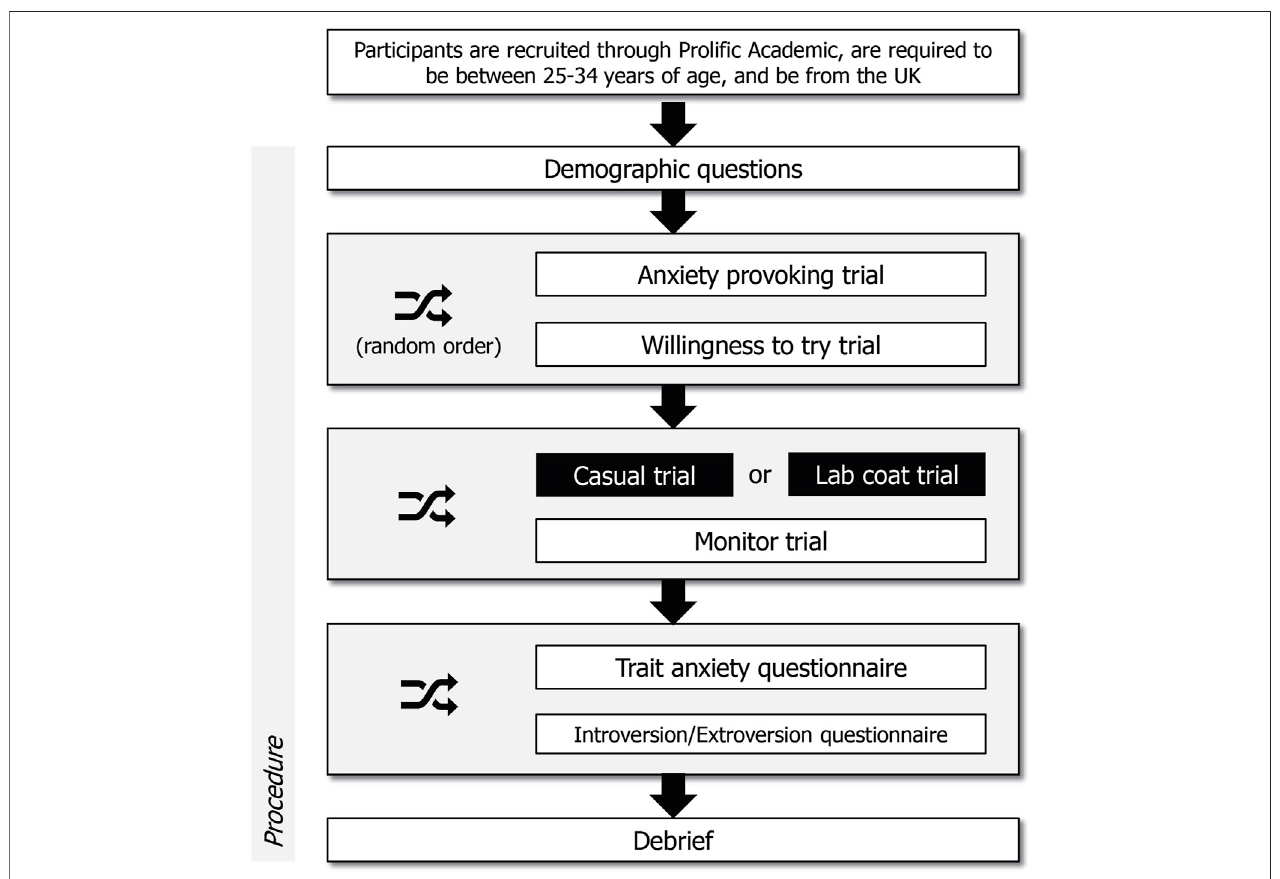
FIGURE 3 | illustrating the study design and procedure ( fi gure-type adopted from Mirams, Poliakoff, Brown & Lloyd, 2013). All participants undertook all experimental trials (dashed border; repeated measures design) except for the lab Coat vs Casual trials (black background; between-subject design), where participants randomly undertook only one such